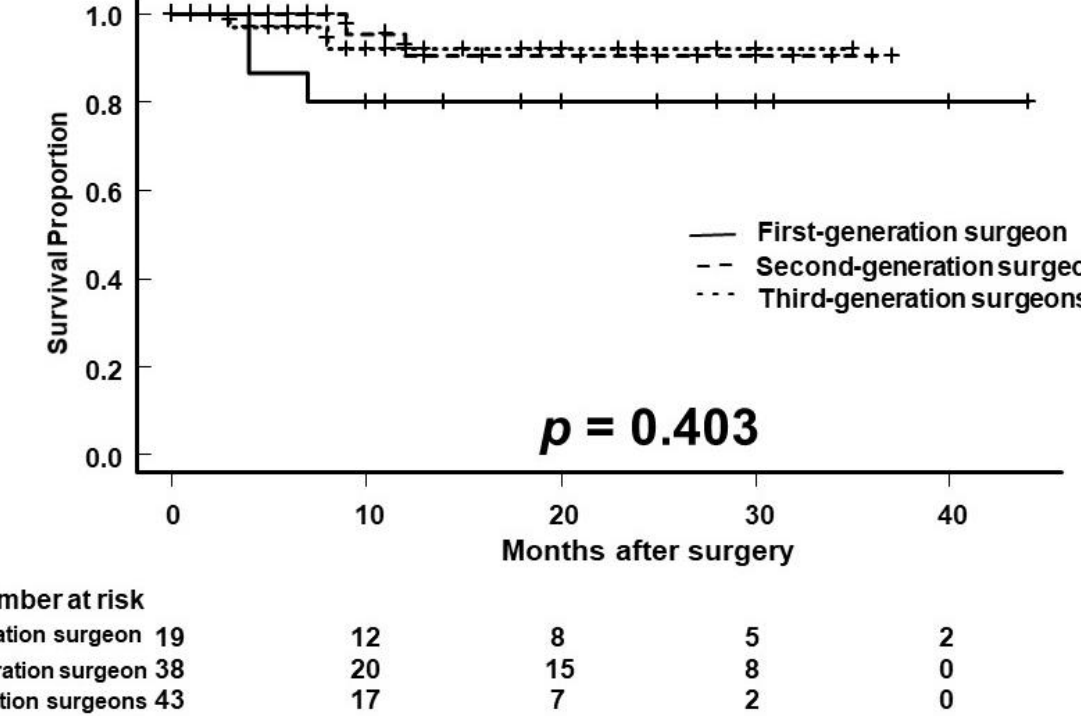
Figure 2. Kaplan – Meier analysis of overall survival (OS). The 1-year OS was 80.0%, 90.4%, and 92.0% in the first-, second- and third-generation surgeons, respectively.